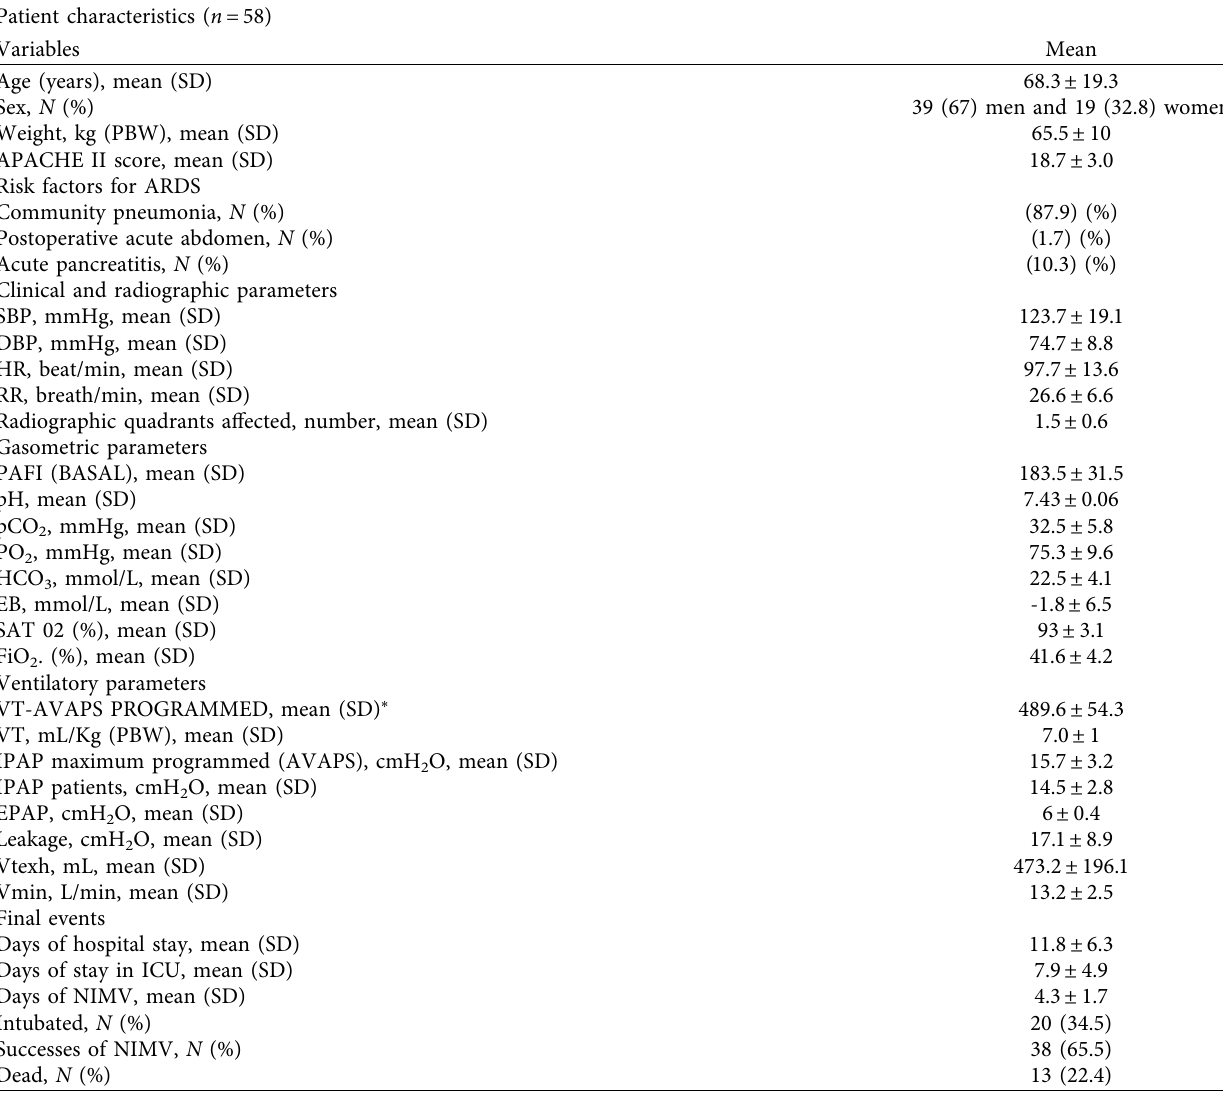
Table 1: Baseline characteristics of the study